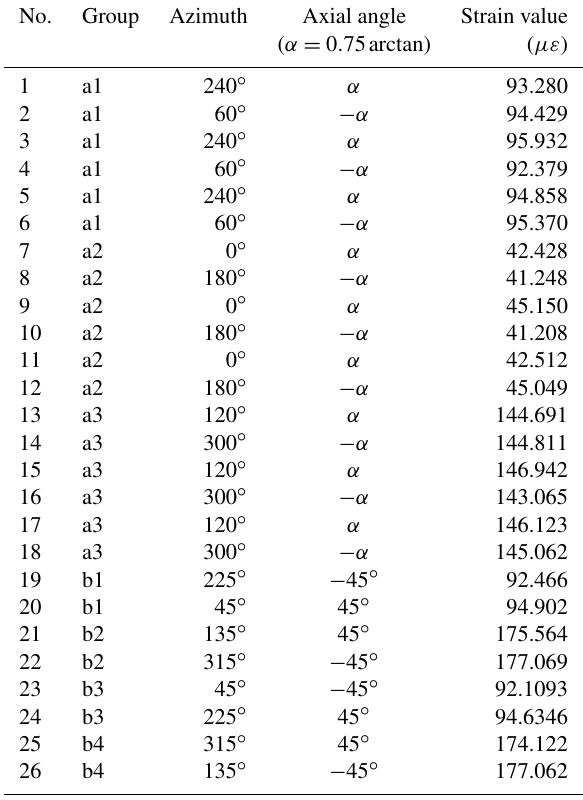
Table 7. Strain value table of FBG